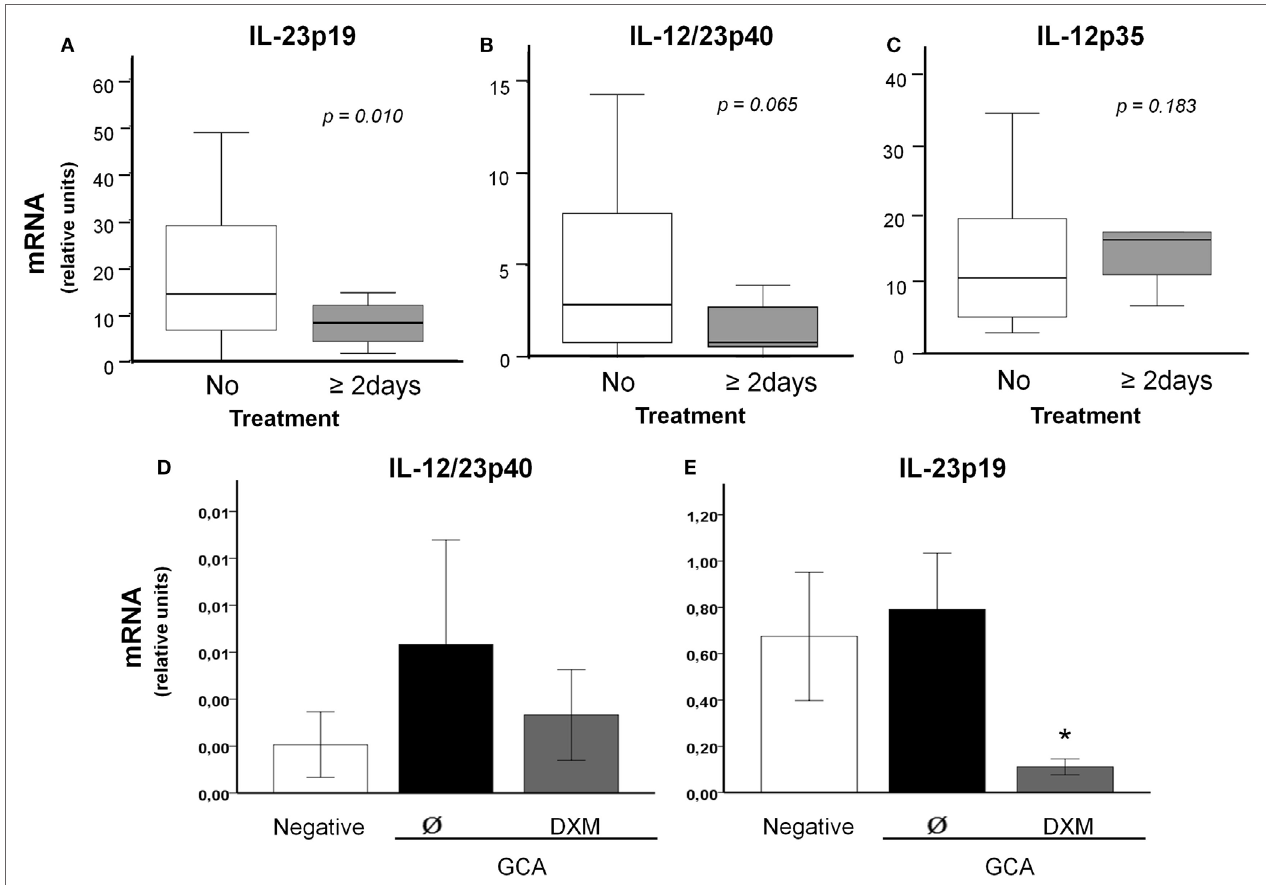
FigUre 4 | Decreased IL-12/23p40 and IL-23p19 expression in temporal arteries from treated GCA patients. IL-23p19 (a) , IL-12/23p40 (B) , and IL-12p35 (c) expression (relative units) in temporal arteries from 36 treatment-naïve and 14 prednisone-treated GCA patients. (D) mRNA IL-12/23p40 expression and (e) mRNA IL-23p19 expression on cultured biopsies (negative and GCA) , showing the effect of dexamethasone (DXM) in GCA arteries. Bars represent mean ±